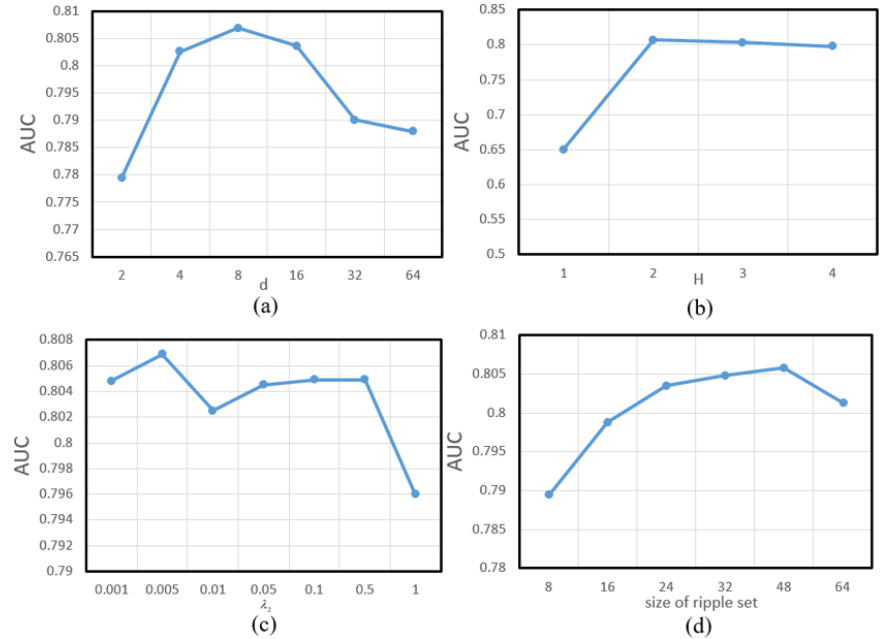
Figure 6. Parameter sensitivity analysis of RippleNet model. ( a ) The influence of the change of matrix embedding dimension d on model AUC index. ( b ) The influence of the change of the maximal hop number H on model AUC. ( c ) The influence of the change of the parameter λ 2 on model AUC. ( d ) The influence of the size of ripple set on model AUC. Table 10. Optimum performance parameters of RippleNet model.